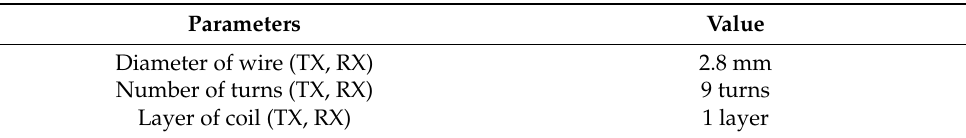
Figure 11. Setup for 3D EM solver: ( a ) aerial view; ( b ) top view; ( c ) observation point of the leakage magnetic field. Table 2. Mechanical parameters of EM simulation.